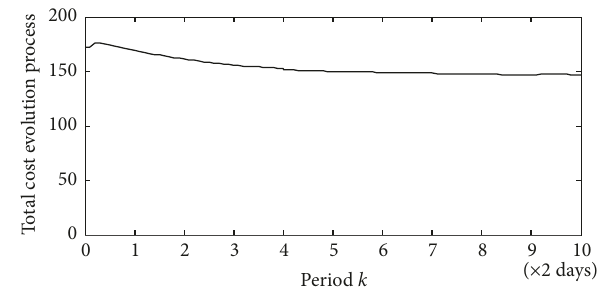
Figure 8: Evolution process of total cost under the second initial inventory statuses ( ×10 7